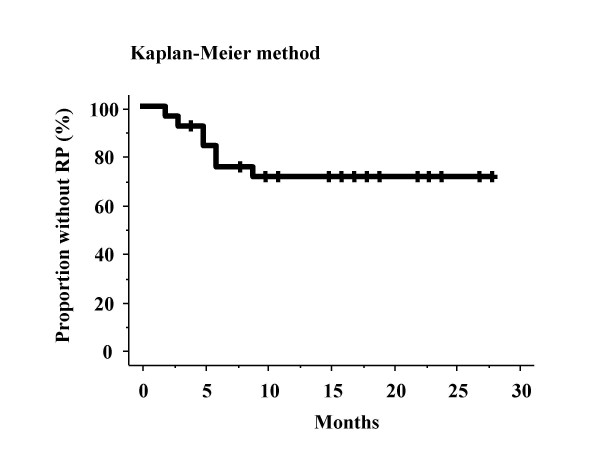
Kaplan-Meier plot of time from treatment until RP grade2 to 5. There were seven patients: one had RP at 2 months, one at 3 months, one at 9 months, two at 5 months, and two at 6 months.